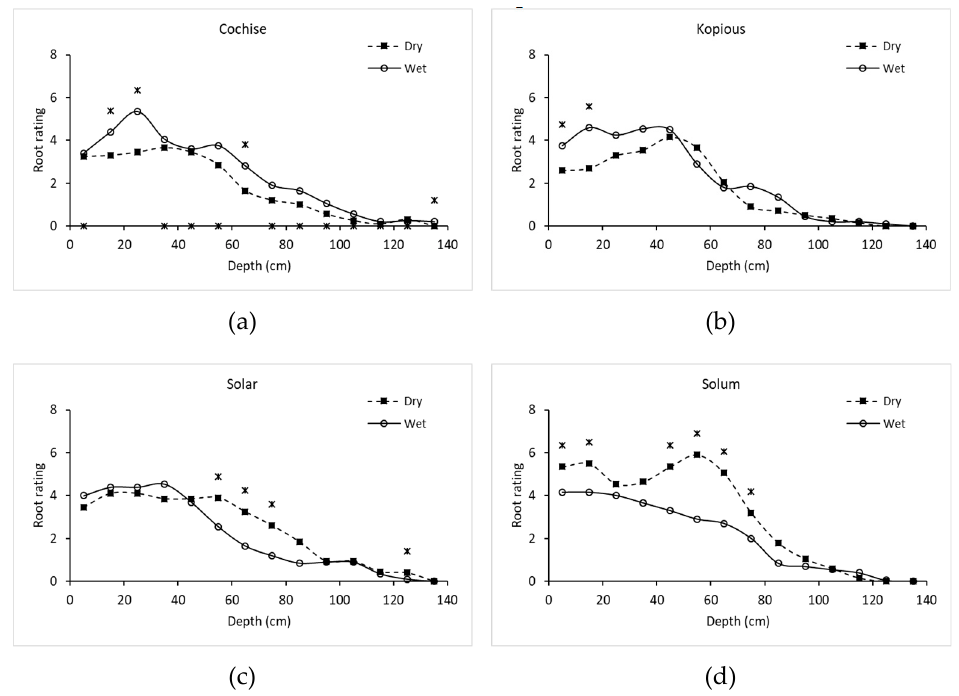
Figure 2. Root density ratings at depths from profile walls dug at physiological maturity under high irrigation (dry) and low irrigation (wet) by variety: ( a ) “Cochise”; ( b ) “Kopious”; ( c ) “Solar”; ( d ) “Solum”. Crossmark “ × ” indicates significant difference in root density at p < 0.05.